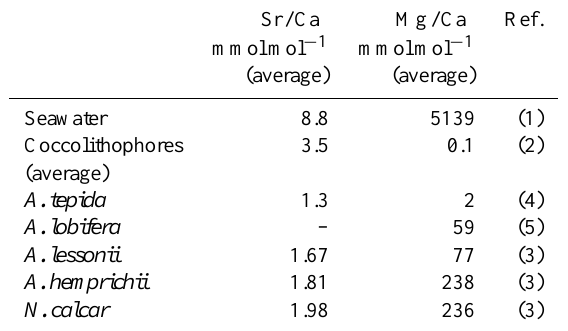
Table A2. Values for Sr/Ca and Mg/Ca for seawater, coccol- ithophores and different Foraminifera species reported in the litera-